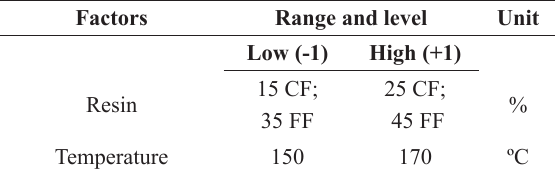
Range and level of factors used in two-level factorial design to produce particle